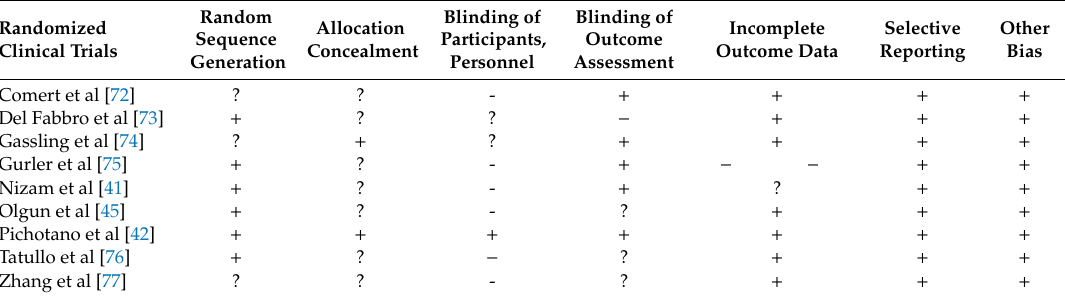
Table 3. Risk of Bias of included randomized clinical